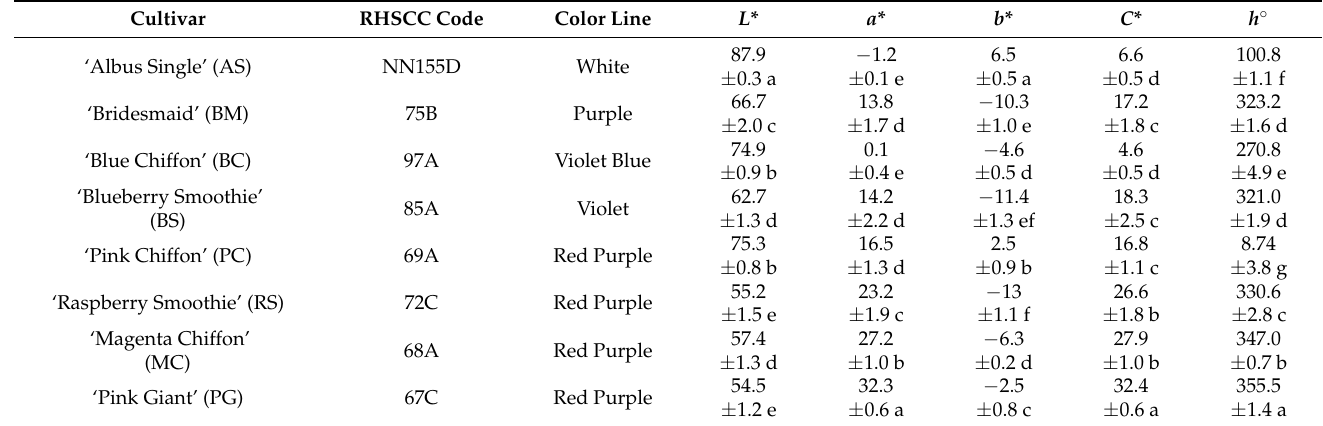
Table 1. Cultivars of Hibiscus syriacus used in this study, along with their chromatic parameters.